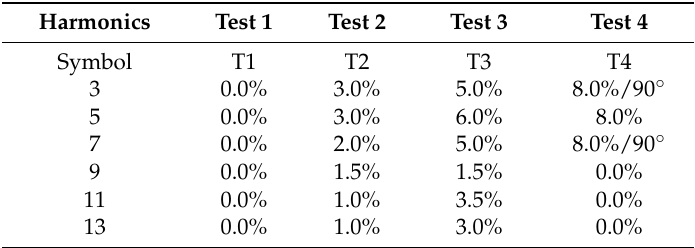
Table 2. Test voltage parameters during tests in an isolated power